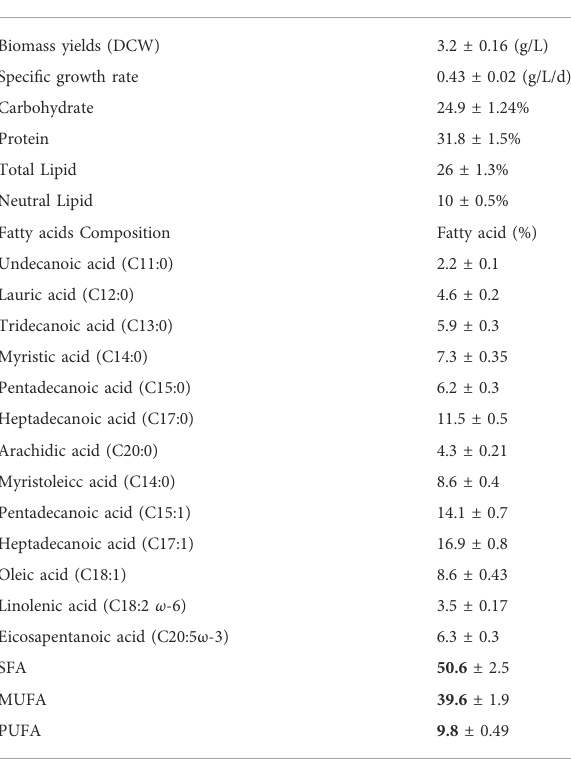
TABLE 2 Composition analysis of Coelestrella sp. SVMIICT5 after cultivation.